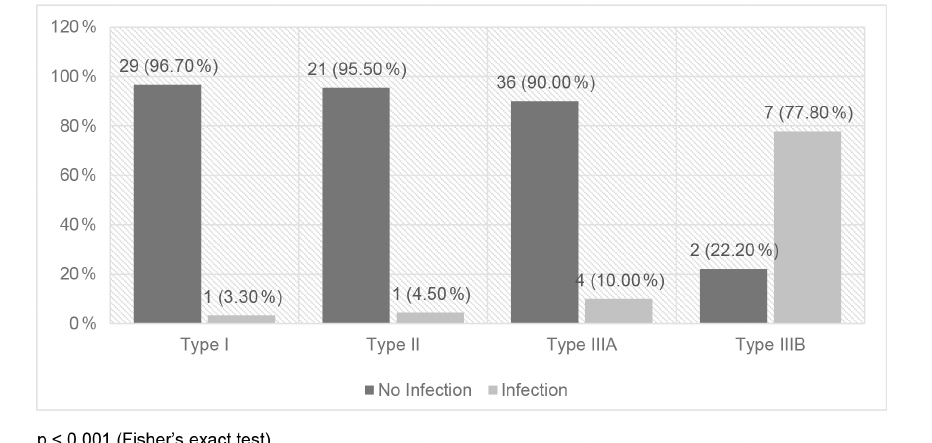
Figure 2. Association between fracture severity and infection ( N = 101). p< 0 . 001 (Fisher’s exact